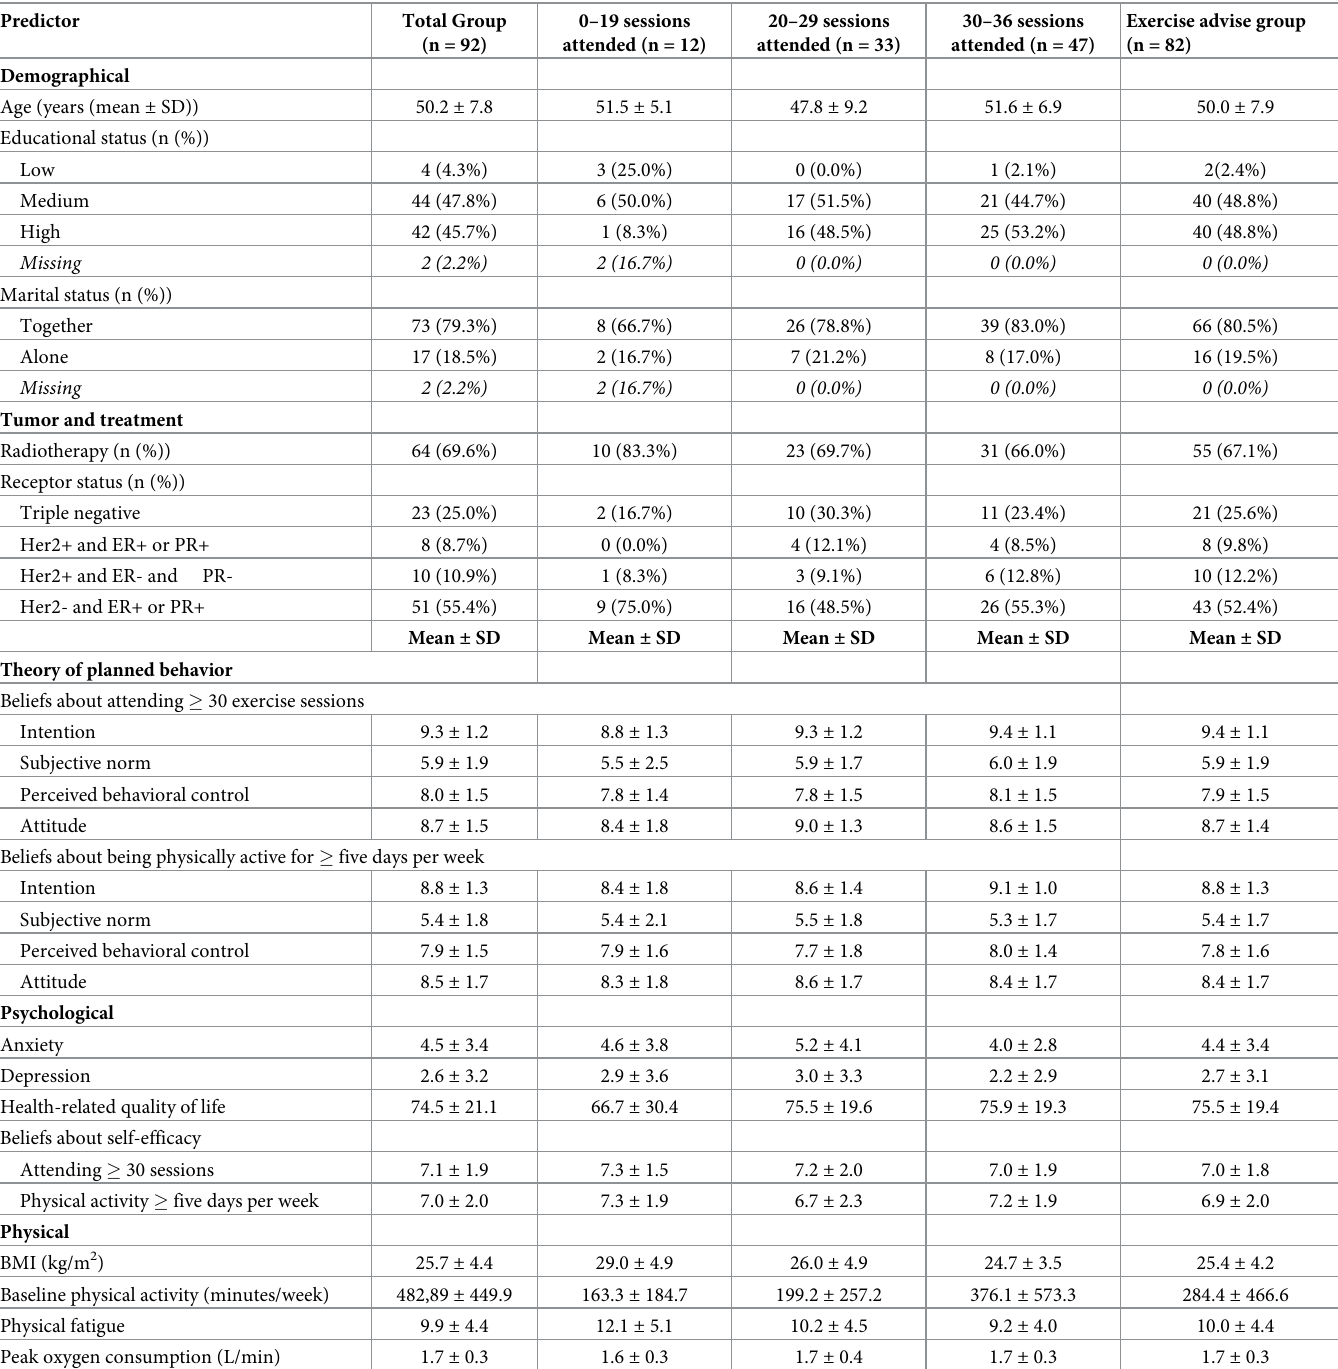
Table 1. Baseline characteristics of 92 breast cancer patients, reported for the total group and stratified according to attendance.